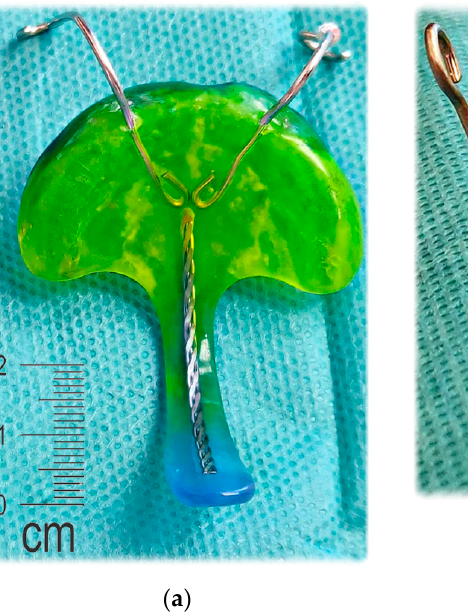
Figure 3. Conventional design of Tübingen Palatal Plate (TPP) made by laboratory technician with metallic hooks for extraoral pull and safety metallic wire in the body of oropharyngeal spur: ( a ) Lingual view; ( b ) Palato-lateral view. Scale is in cm.